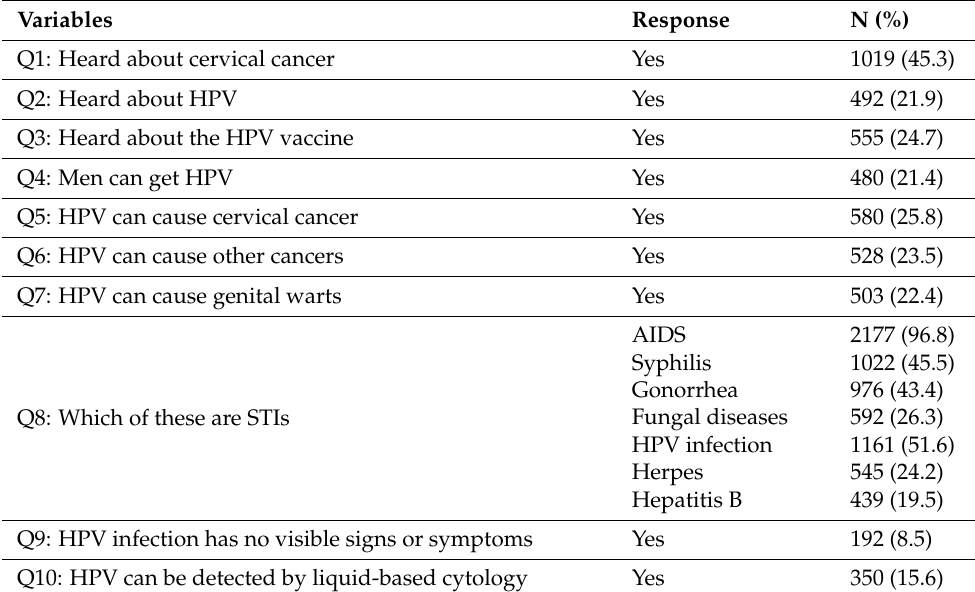
Table 2. Awareness and knowledge about HPV infection among the study participants ( n = 2248).